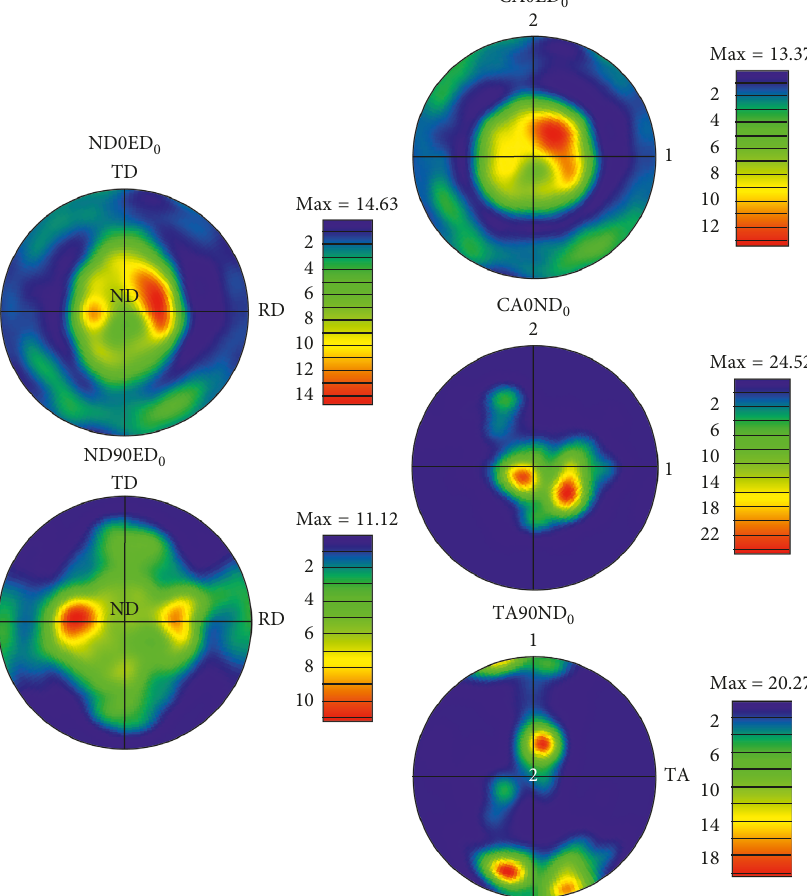
Figure 8: Predicted final texture ({0001} pole figures) using crystal plasticity simulations under the five set of mechanical tests performed in this study: plane strain compression (ND0ED 0 and ND90ED 0 ), simple compression (CA0ED 0 and CA0ND 0 ), and uniaxial tension (TA90ND 0